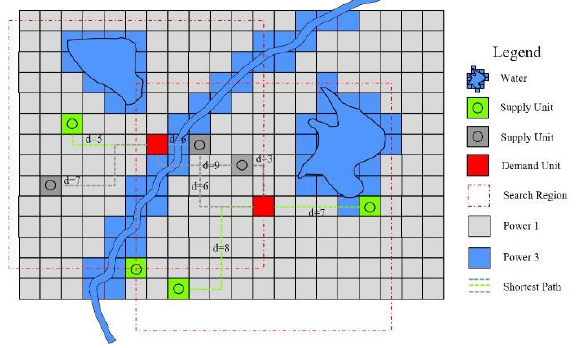
Figure 4 . Distance metric based on raster map 3 RESULTS Figure 5 . Evaluation results of spatial equity in the study area